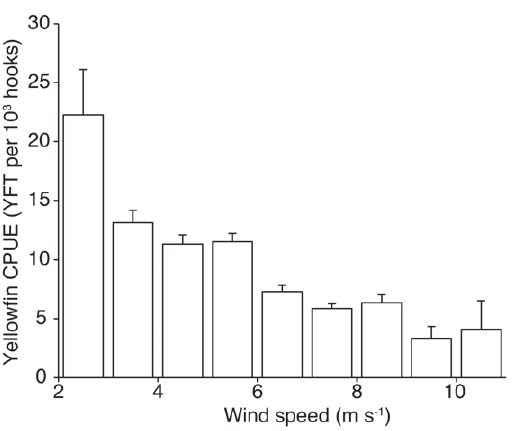
Figure 7. Yellowfin tuna CPUE in relation to wind speed. Histograms show mean catch per unit effort (CPUE) of yellowfin tuna in the Gulf of Mexico, with respect to wind speed of the longline set. Error bars indicate 1 sd (based on 1000 bootstrap samples).